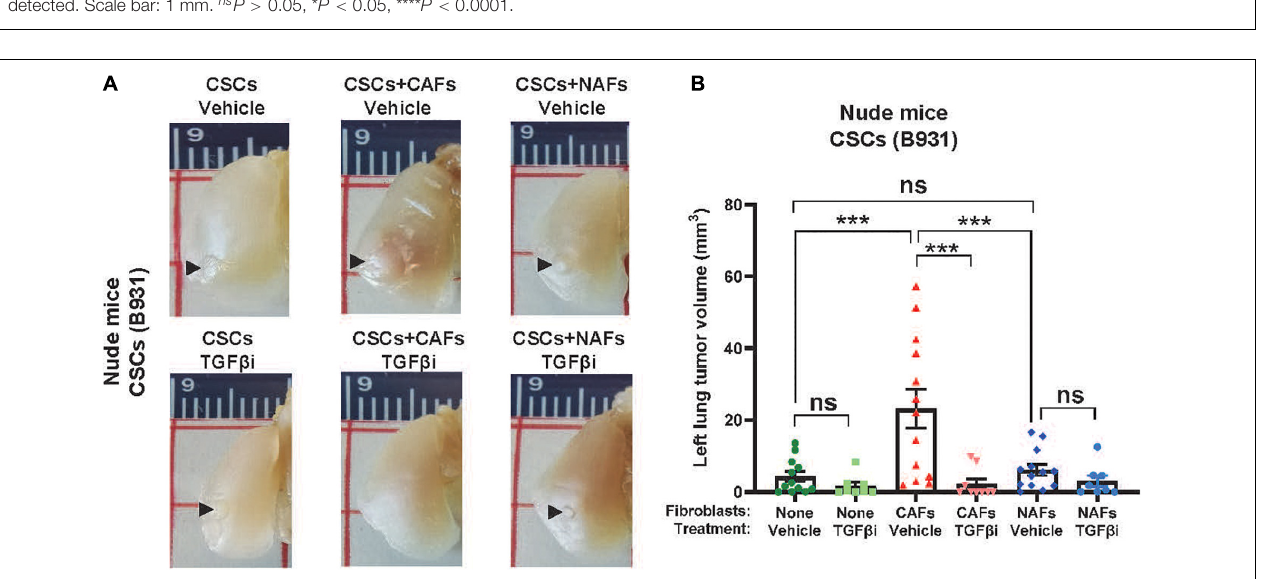
FIGURE 5 | Cancer-associated fibroblasts facilitated TGF β -dependent CSC cell seeding and expansion in the left lung. (A) Representative images of left lung tumors formed after injecting 100 flow sorted B931 SP CSCs with 500 CAFs or NAFs. Mice were treated with vehicle or TGF β i as indicated. (B) Quantification of left lung tumor volumes at the time of harvest. ns P > 0.05, *** P <